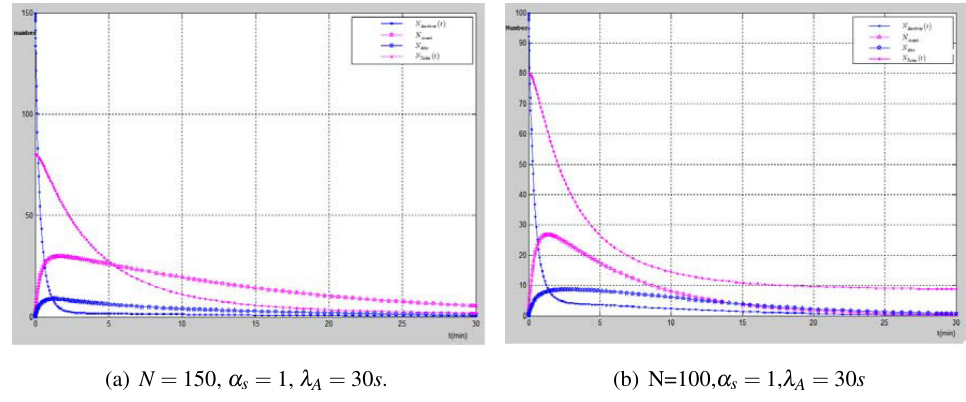
Fig. 1 The number of task state with respect to time at different